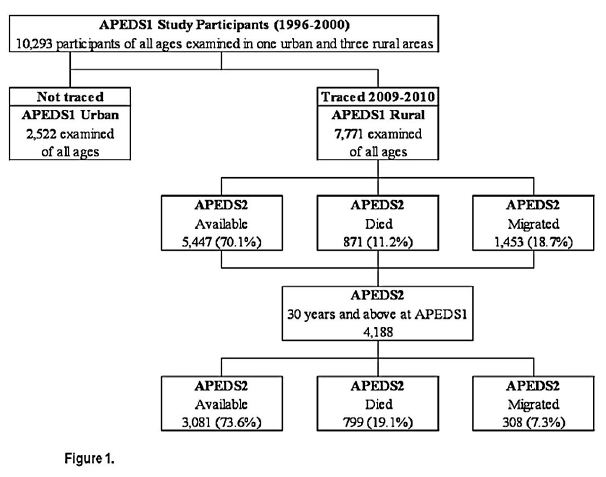
Figure 1. Availability status of participants at the time of